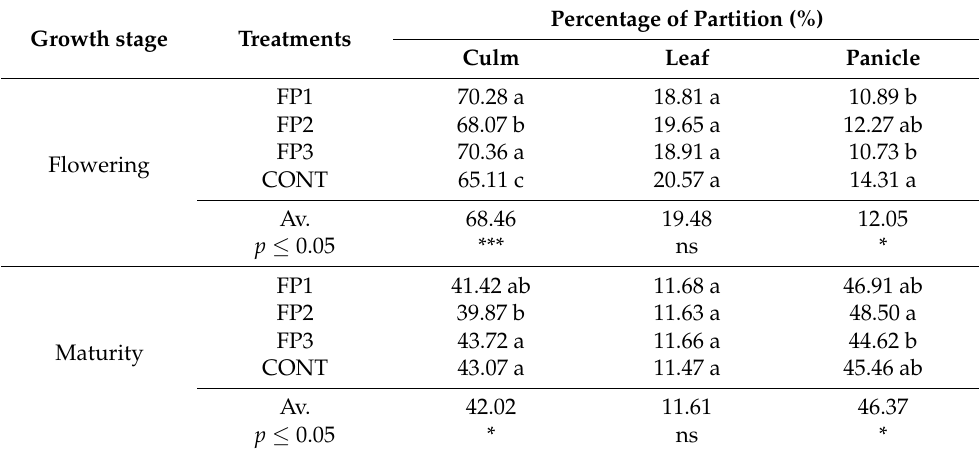
Table 4. Percentages of dry matter partitioned to the panicles, leaves, and culms of sample rice plants at the flowering and maturity stages following treatment with different combination of chemical fertilizer and plant-growth-promoting rhizobacteria.